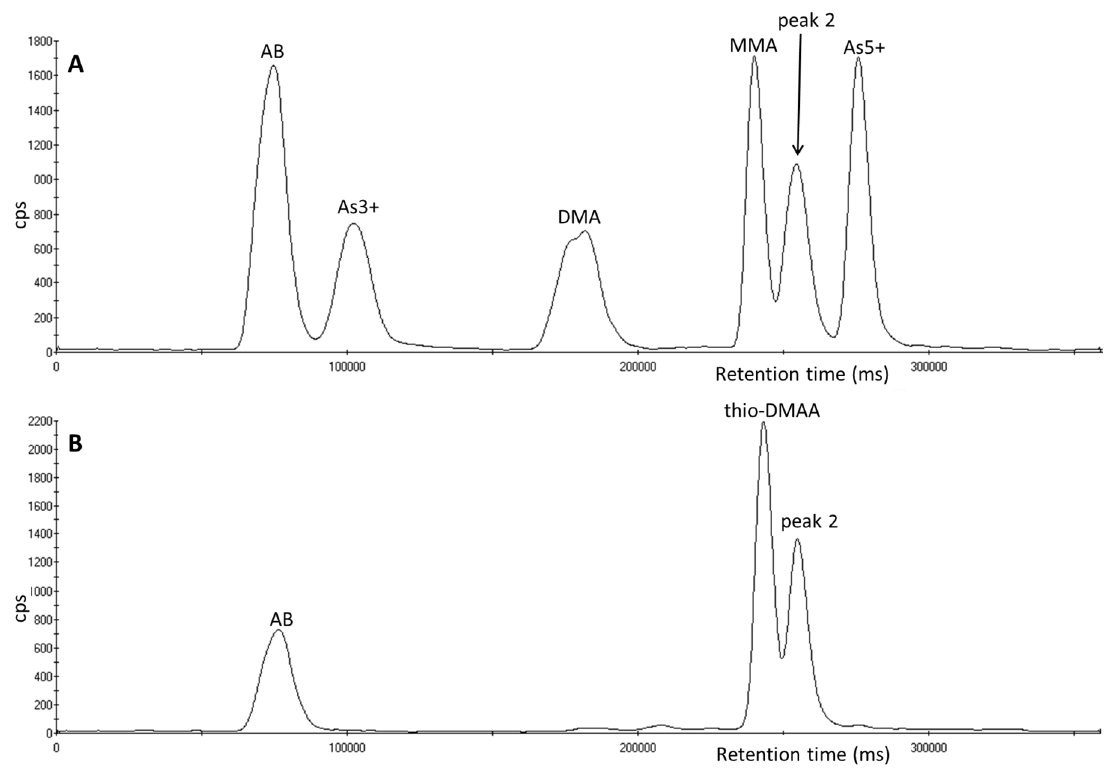
Figure 5. Chromatograms of arsenic species analyzed using an ESI OneFAST system coupled to a Dionex AG7 anion exchange column and ICP ‐ MS using mobile phases 2 mM and 70 mM ammonium carbonate solution. ( A ) Chromatogram of a urine sample containing peak 2 spiked with a 20 μ g ∙ L − 1 standard mix of the five species of arsenic. ( B ) Chromatogram of the urine sample spiked with